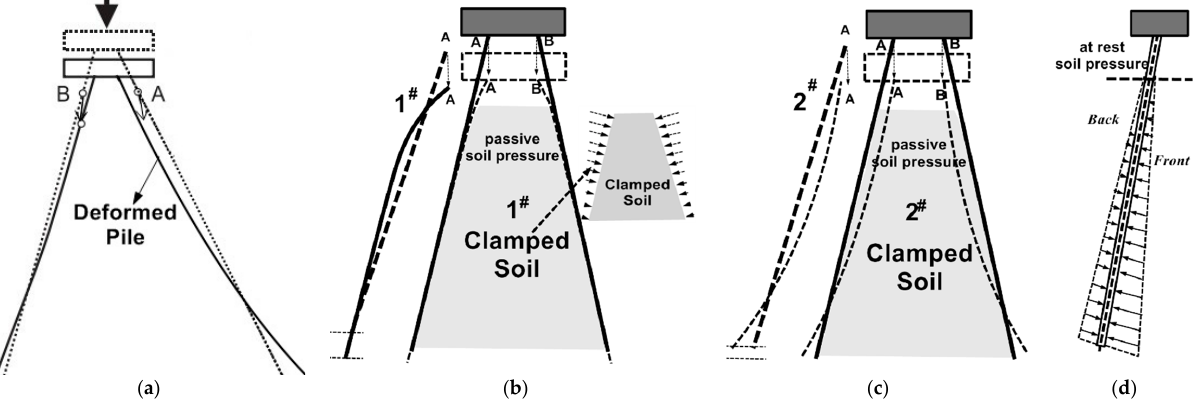
Figure 5. The assumption of the deformation mode of the symmetrical batter pile under vertical loading. ( a ) Zhang et al.’s study, ( b ) deformation assumption No.1, ( c ) deformation assumption No.2, ( d ) the at-rest soil pressure in the front and back areas of the batter pile.